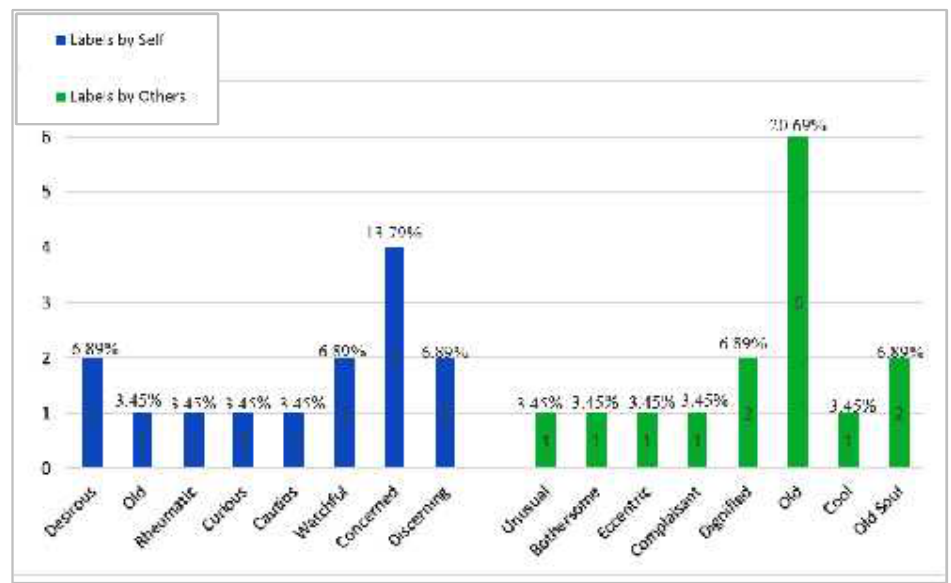
Figure 2: Frequency and Percentage of Dr. Heidegger’s